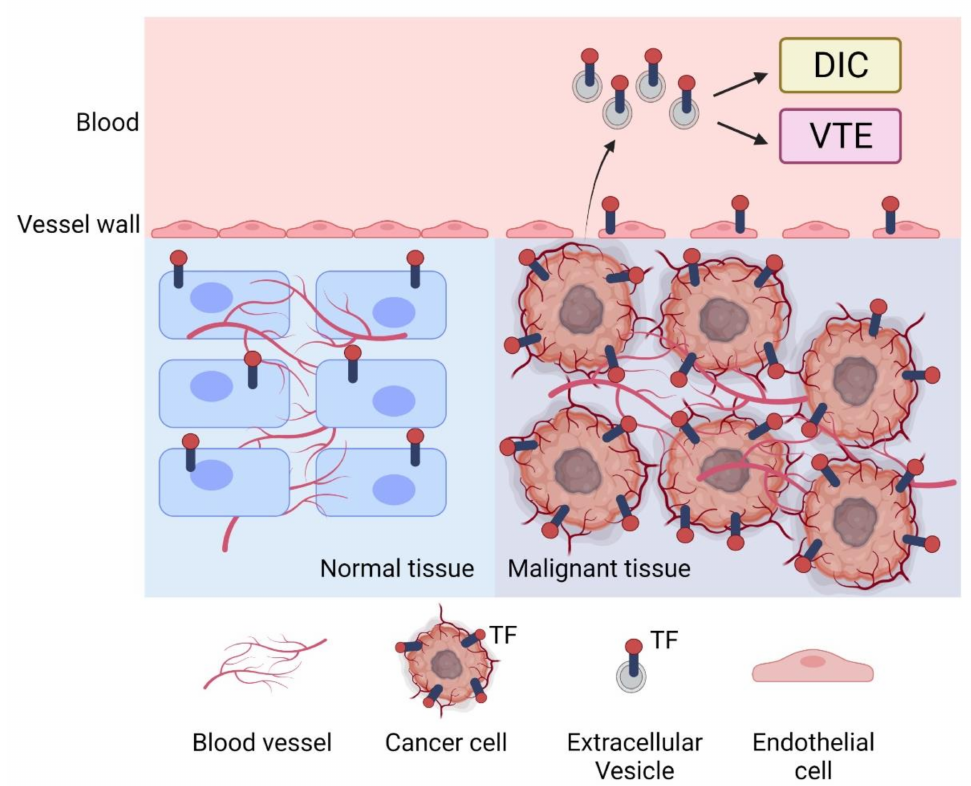
Figure 1. Tissue factor and cancer. Tissue factor (TF) contributes to tumor growth and angiogenesis in malignant tissue. Tumor cells release TF-positive extracellular vesicles that can cause either venous thromboembolism (VTE) or disseminated intravascular coagulation (DIC) in cancer patients. Figure is created with